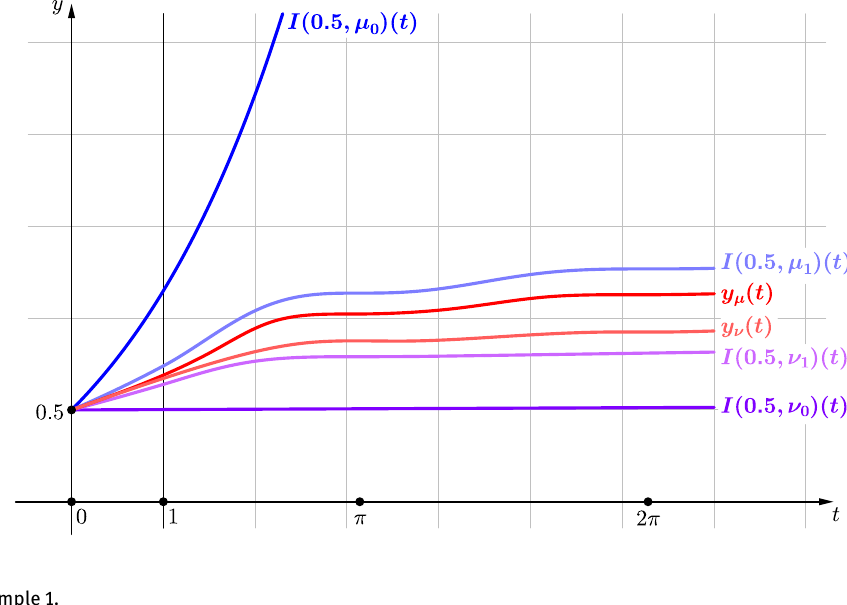
Fig. 4: To Example